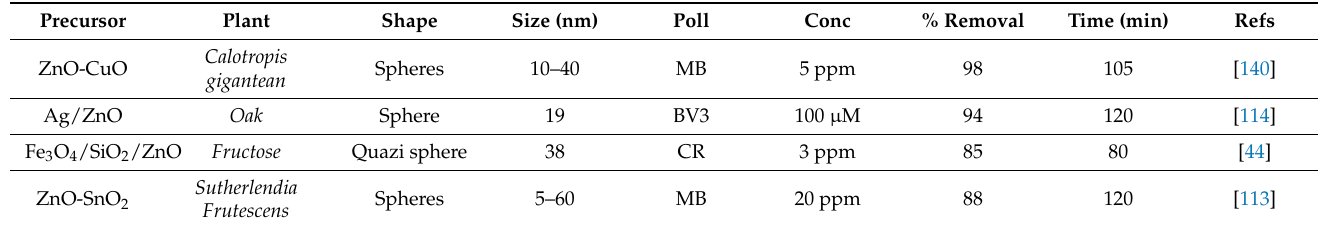
Table 6. Green derived bimetallic NPs supporting ZnO for dye